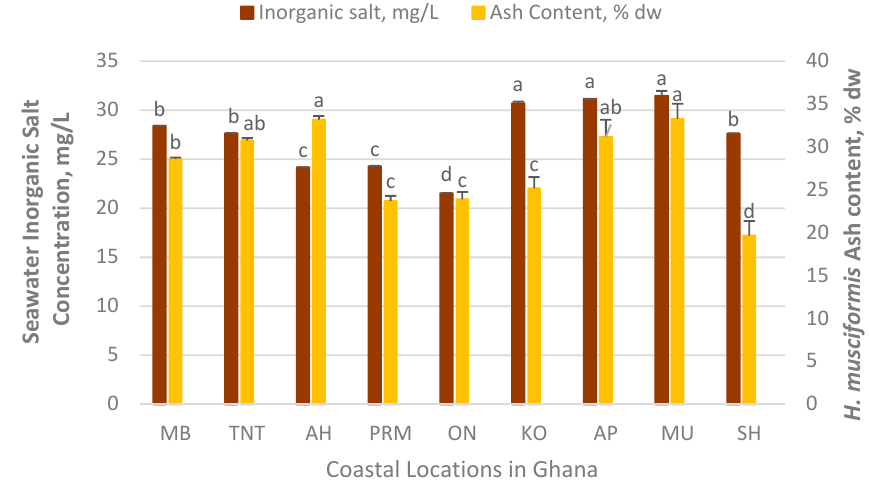
Figure 7. Inorganic salt content was the combined levels of Na, K, Ca, Mg, Cl, SO 4 , and CO 3 , respectively. Seawater and seaweed samples were obtained from different coastal location in Ghana selected for this study. Means with different letters ( i.e. , a, b, c, and d) are significantly different p < 0.05, (ANOVA, Turkey’s 95% confidence intervals).